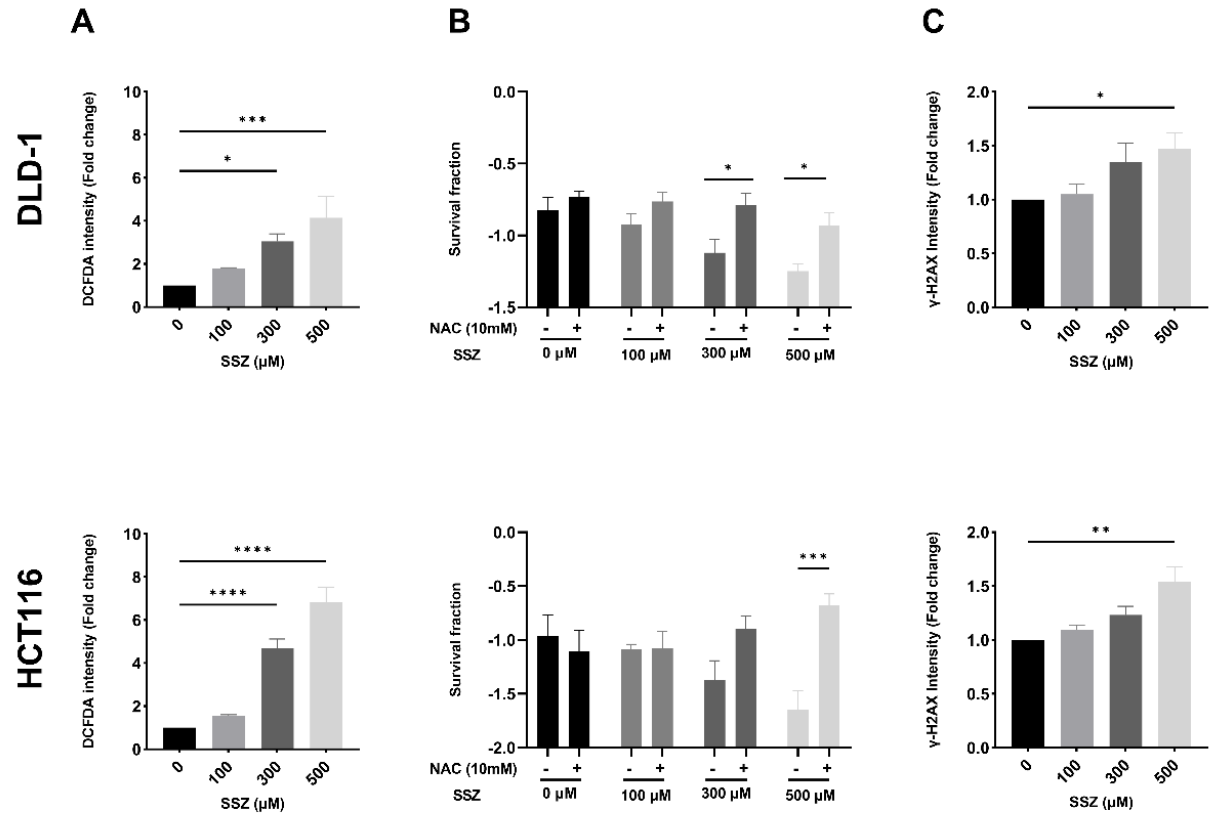
Figure 4. SSZ treatment increases the levels of ROS in hypoxic colorectal cancer cells, leading to DNA damage and radiosensitization. DLD-1 and HCT116 cells were treated (16 h) under hypoxic conditions (1%) with the indicated concentrations. When applicable, NAC was added 1 h prior to SSZ treatment. ( A ) Summarizing graph showing ROS levels in DLD-1 (top) and HCT116 (bottom) cell lines. ( B ) Survival fraction of cells after radiation with 8Gy in DLD-1 (top) and HCT116 (bottom) cell lines. ( C ) The amount of DNA double-strand breaks in DLD-1 (top) and HCT116 (bottom) cell lines. Data are represented as mean ± SEM, n ≥ 3. A one-way ANOVA followed by Dunnett’s multiple comparison test or a two-way ANOVA followed by Dunnett’s, or Bonferroni’s multiple comparison test was performed for statistical analyses. * p < 0.05, ** p < 0.01, *** p < 0.001, **** p < 0.0001. Lastly, ROS are crucial for the generation of DNA damage following IR [23,26]. There- fore, the amount of DNA double-strand breaks after SSZ treatment was determined. SSZ dose-dependently increased the amount of DNA double-strand breaks (up to 1.5-fold) in both DLD-1 and HCT116 cells, reaching statistical significance with the highest dose of SSZ (500 µ M) (Figure 4C). Since NAC only partly reverses the radiosensitizing effect of SSZ, induction of DNA double-strand breaks by increased ROS levels is not the only mechanism responsible for the observed radiomodulatory properties of